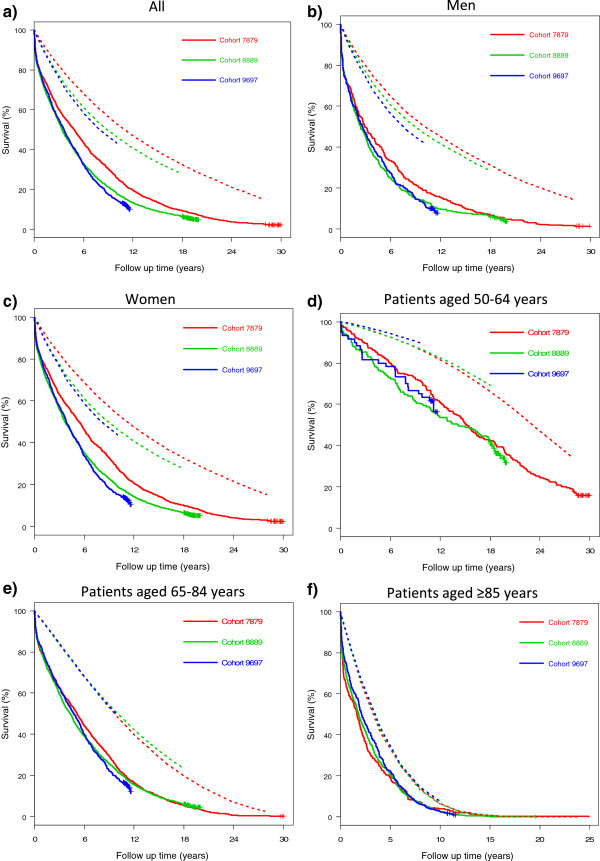
Expected survival and observed survival by cohort. Expected survival (dotted curves) and observed survival (continuous curves) by cohort. a) All, b) Men, c) Women, d) Patients aged 50–64 years, e) Patients aged 65–84 years, and f) Patients aged ≥85 years (Please note slight difference in the time scale). A substantially higher mortality in hip fracture patients, than in the corresponding background population, is shown. The better survival in the 1978–79 cohort in the analyses not stratified on age is explained by the younger patients in this cohort.